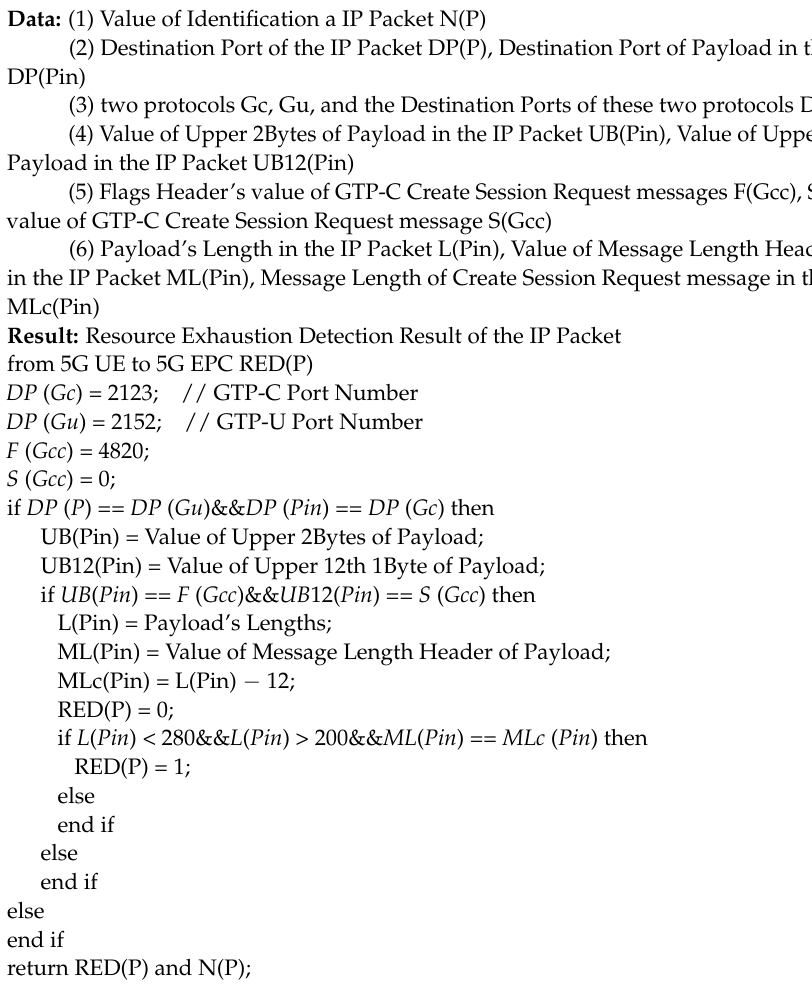
Algorithm 2. Resource exhaustion traffic detection